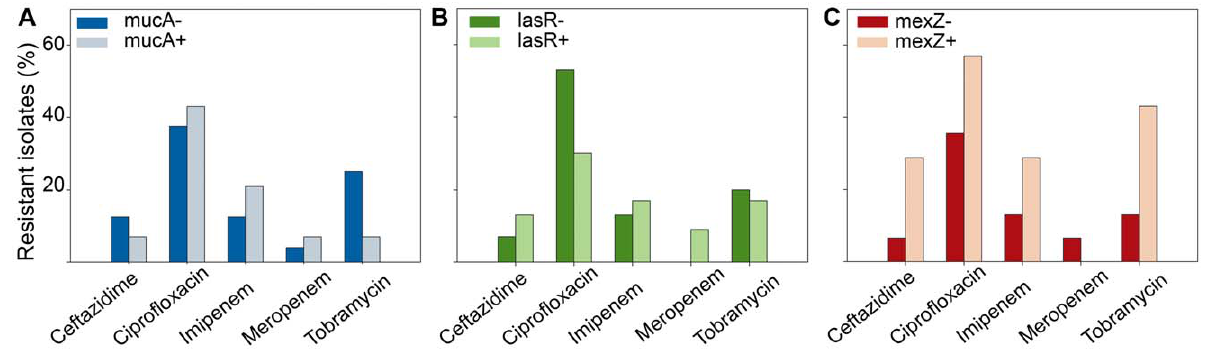
Figure 3. Association between antibiotic resistance and inactivation of mucA , lasR and mexZ. (A) Differences in antibiotic resistance in the P. aeruginosa isolates harboring mutations in mucA (mucA-) respect to those without mutations in mucA (mucA + ). Data is expressed as the percentage of resistant isolates to ceftazidime, ciprofloxacin, imipenem, meropenem and tobramycin in mucA- and mucA + isolates. (B) The same analysis was carried out in lasR- and lasR + isolates and (C) mexZ- and mexZ + isolates. In the three genes, the observed differences were not significant (Fisher’s exact test) for any of the tested antibiotics.